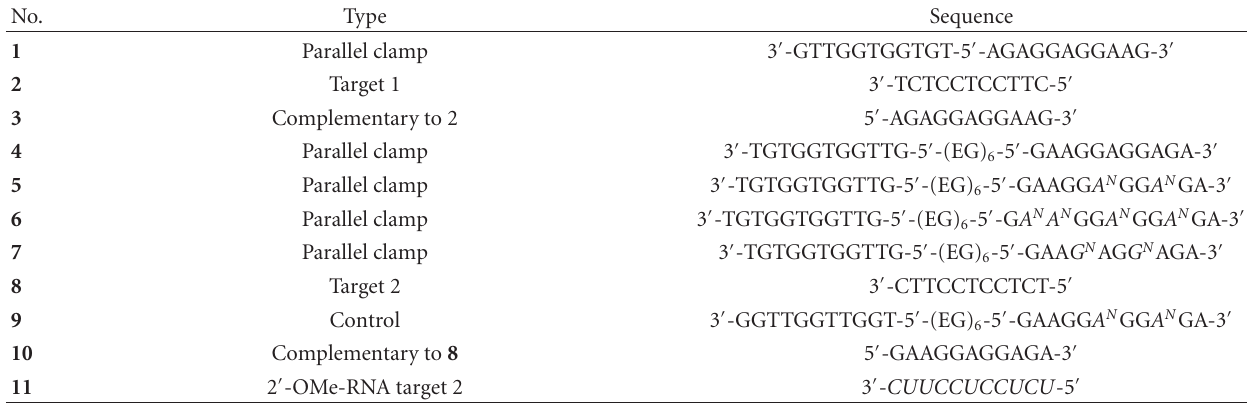
Table 1: Sequences of the G,T-parallel clamps, control oligonucleotides, and their